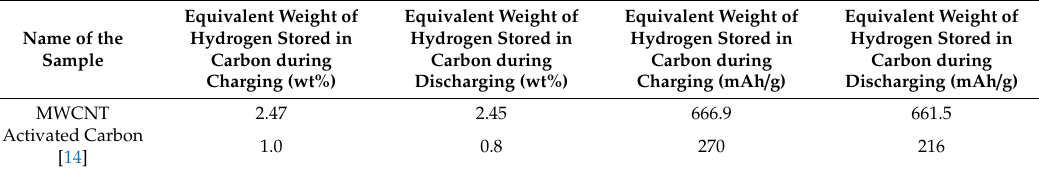
Table 13. Comparison among the obtained results and those reported in literature.